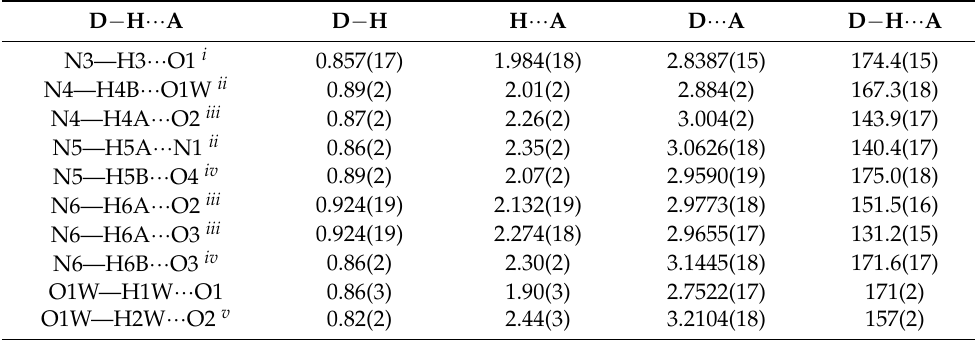
Figure 21. ( a ) A packing diagram for guanidinium 5-nitrouracilate monohydrate, viewed down the a axis, showing the layer formation. Hydrogen bonds are shown as dashed lines. One of the centrosymmetric dimers is highlighted in solid green. ( b ) Layers seen from one of the sides. Table 8. Hydrogen bond geometry of guanidinium 5-nitrouracilate monohydrate ( Å, ◦ ).